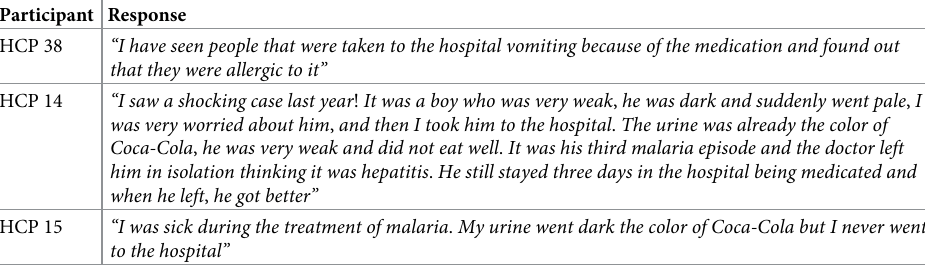
Table 1. Signs of hemolysis—IDIs with